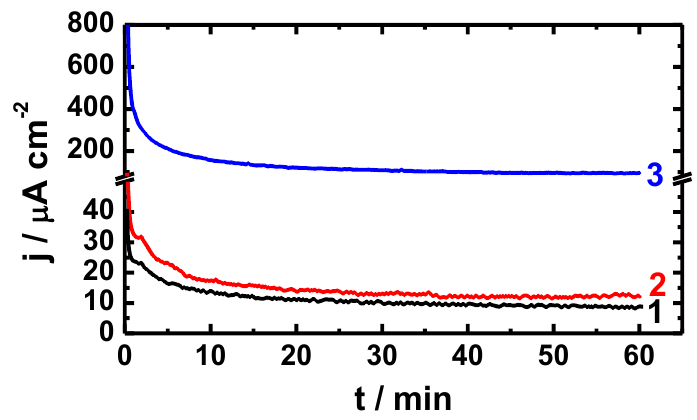
Figure 3. Potentiostatic current-time curves obtained at −100 mV for the Al–TiC composite sintered at ( 1 ) 900, ( 2 ) 1100, and ( 3 ) 1300 °C after 1 h immersion in 3.5% NaCl